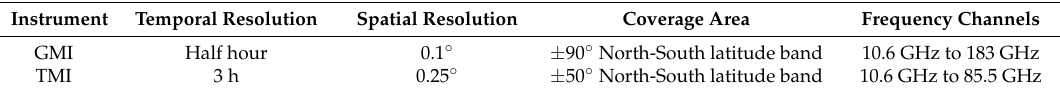
Table 2. Metadata of satellite precipitation products. GMI = global precipitation measurement microwave imager. TMI = tropical rainfall measurement mission microwave imager. Instrument Temporal Resolution Spatial Resolution Coverage